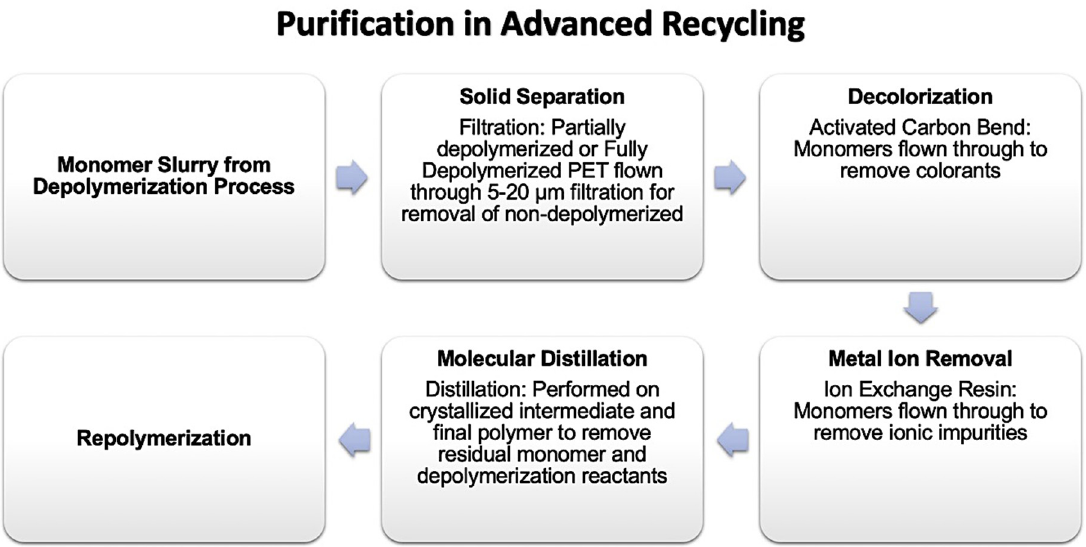
Figure 12. Unit operations in advanced recycling purification.